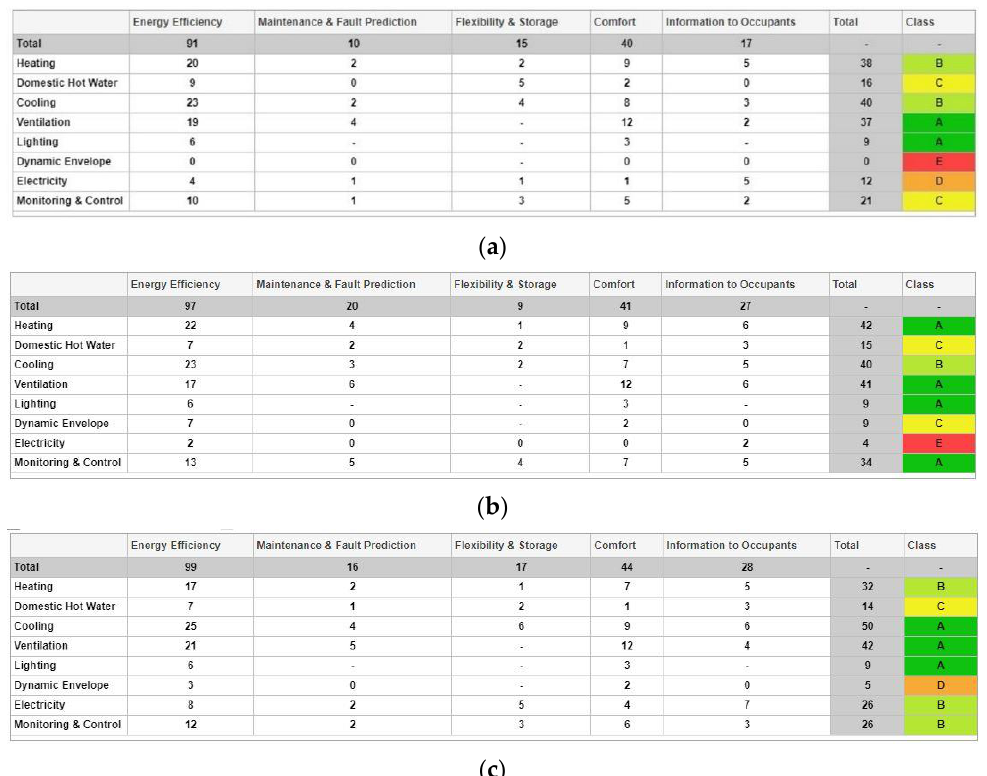
Figure 12. Results of Energy Efficiency Improvements Package in ( a ) Case A, ( b ) Case B, and ( c ) Case C.